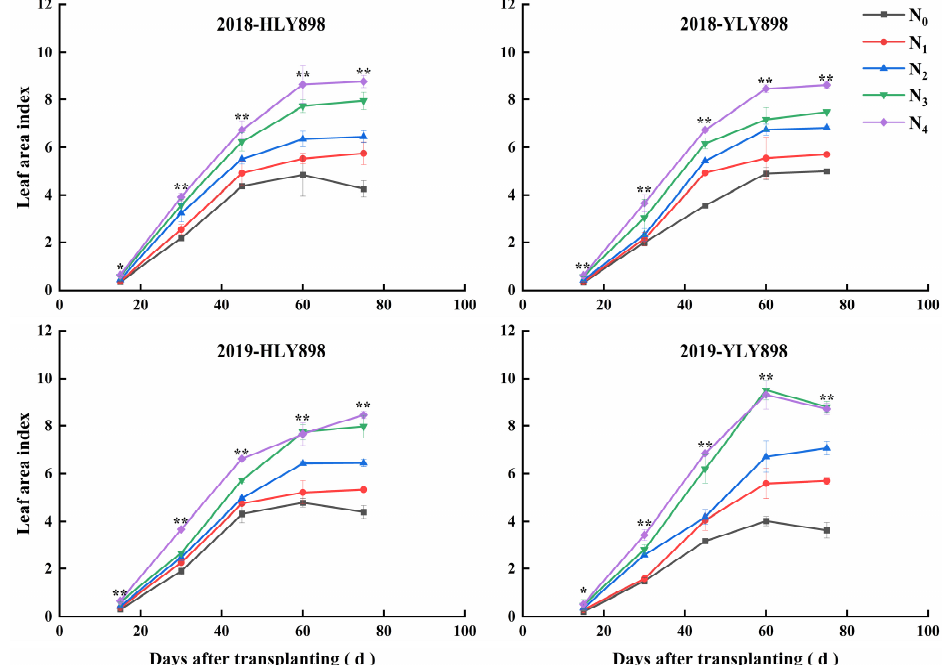
Figure 3. Dynamic changes in the LAI according to days after transplanting (d) shown for the varieties Huiliangyou 898 (HLY 898) and Yliangyou 900 (YLY 900) according to the season (2018 or 2019). * indicates significance at the 0.05 level. ** indicates significance at the 0.01 level.